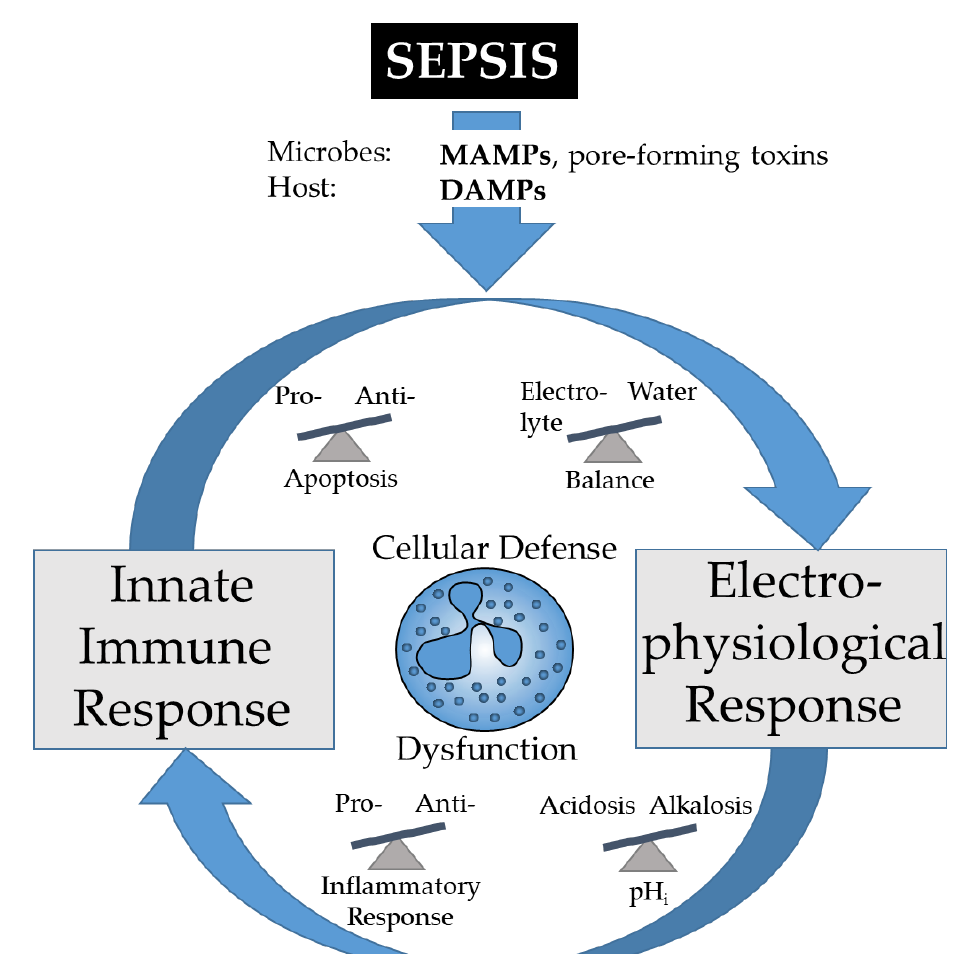
Figure 2. During sepsis, microbe-associated molecular patterns (MAMPs) and damage-associated molecular patterns (DAMPs) may alter various homeostatic balances. The resulting electro-physiological changes including alterations of the intracellular pH (pH i ) will affect the inflammatory response of innate immunity and in consequence, vital cell functions. The mounted immune response including the feed-in of MAMPs and DAMPs will further affect cellular electrophysiology, which finally may form a vicious circle resulting in cellular dysfunction and death.